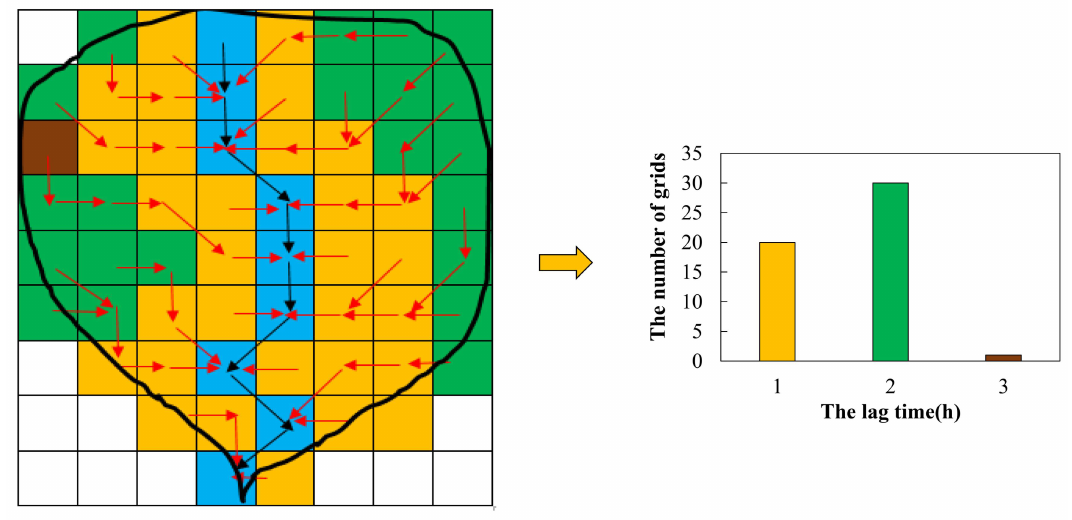
Figure 2. The histograms of the overland flow path lengths.